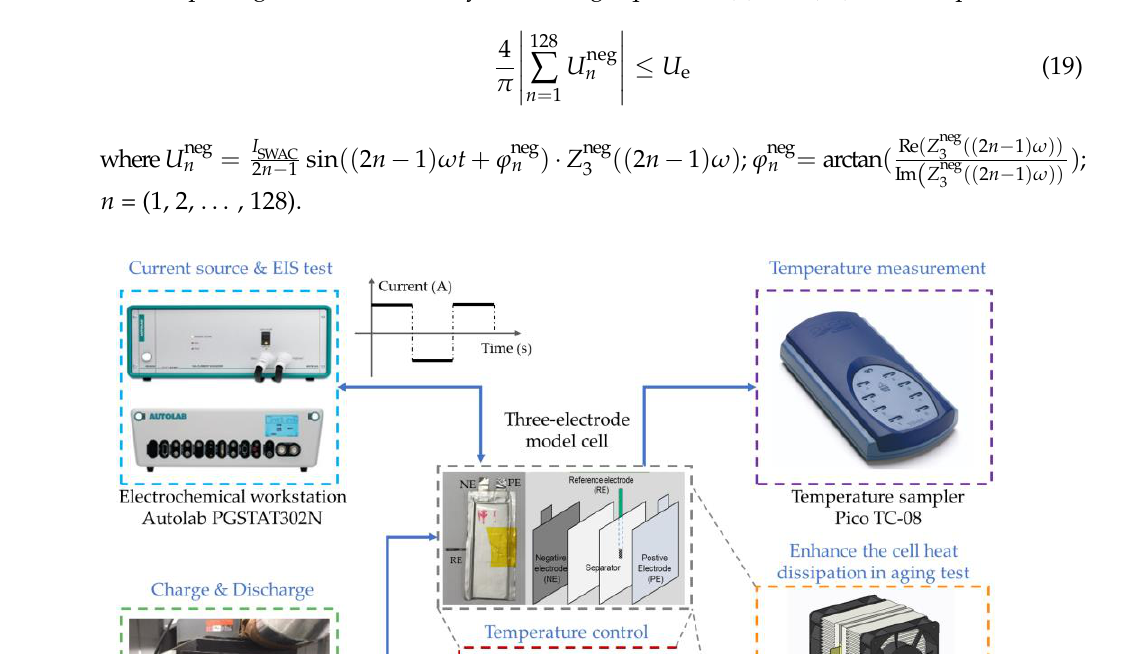
Table 1. Specifications of the test batteries.